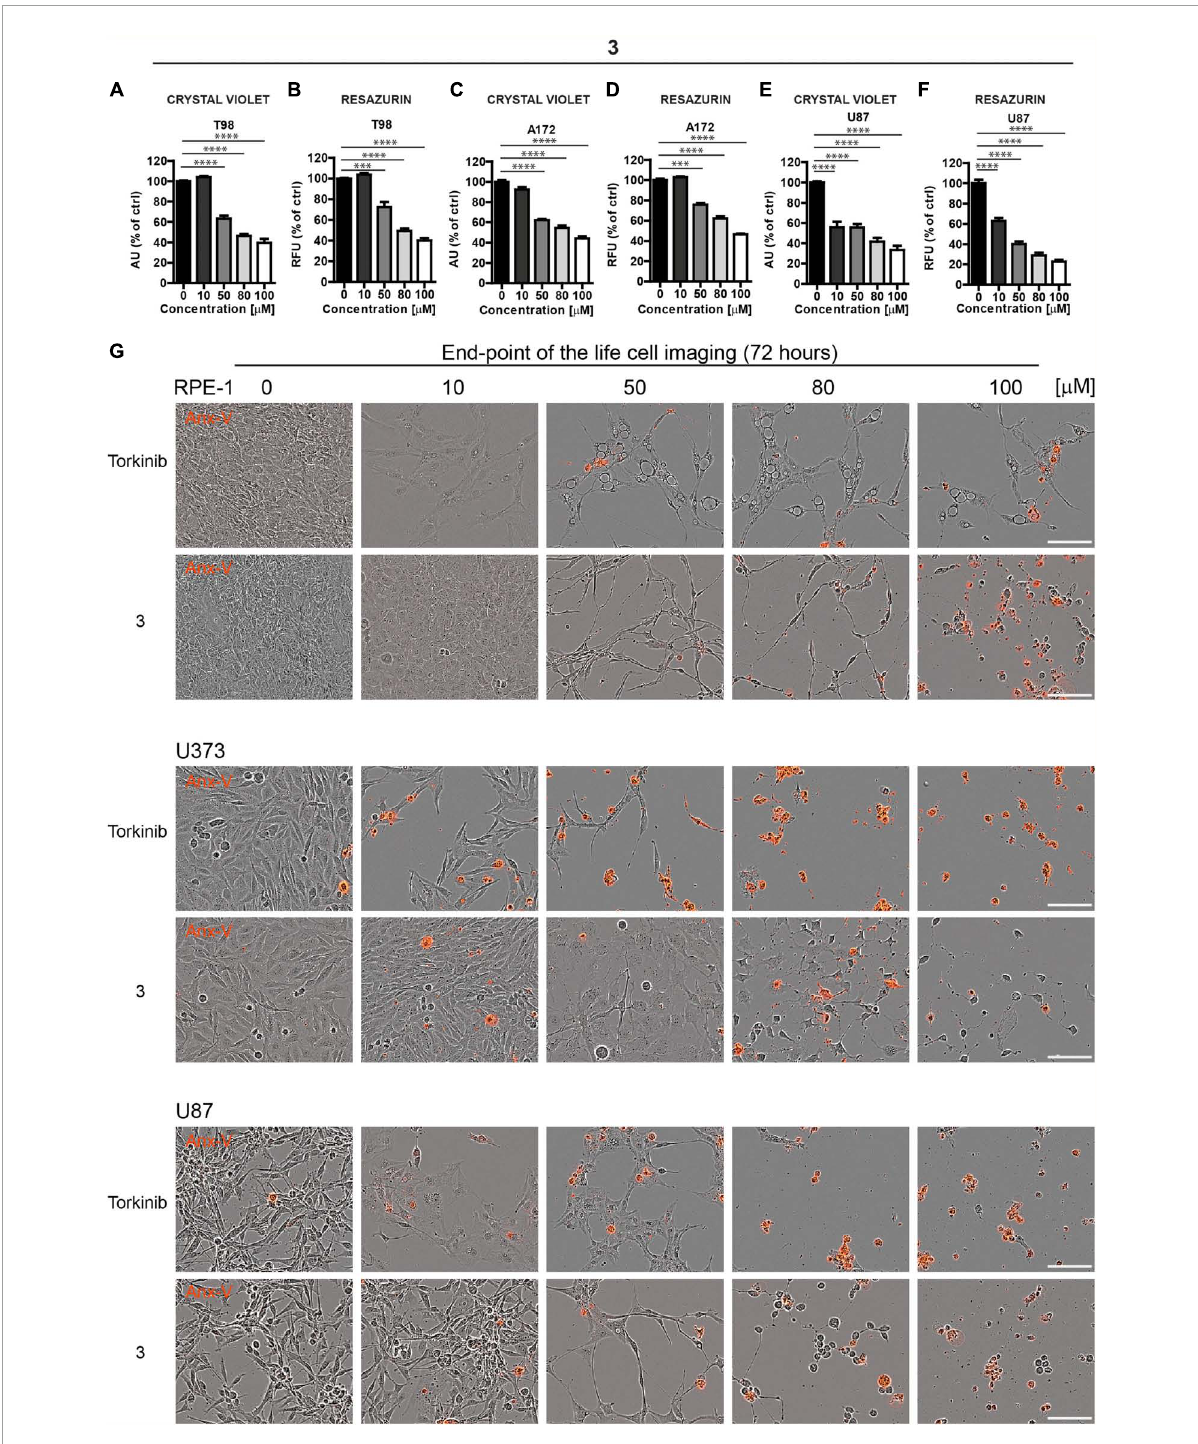
FIGURE5 The cytotoxic effect of new compound 3 on glioblastoma cells. Human glioblastoma T98 (A,B) , A172 (C,D) , and U87 (E,F) cells were exposed to compound 3 in the concentration range of 0–100 µ M for 24 h and assayed by crystal violet (A,C,E) and resazurin (B,D,F) assays. The experiment was done in duplicate. Data were normalized to untreated cells and plotted as mean ± SEM. Two-tailed Student’s t -test, ∗∗∗∗ p < 0.0001; ∗∗∗ p < 0.001. (G) Cytotoxic effect of torkinib and compound 3 (concentration range of 0–100 µ M) demonstrated by time-lapse microscopy (72 h) using Incucyte SX1 platform. End-point images (72 h) are presented. Red color is annexin V staining. Bar, 100 µ